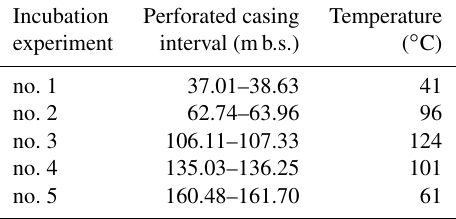
Table 1. List of depth intervals for each incubation experiment, and the corresponding temperatures measured in the 1979 borehole (SE- 01) in 2017 before the initiation of